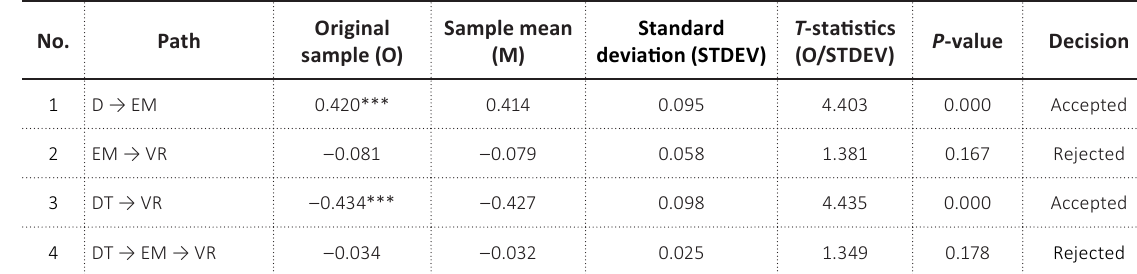
Source: Data processed for